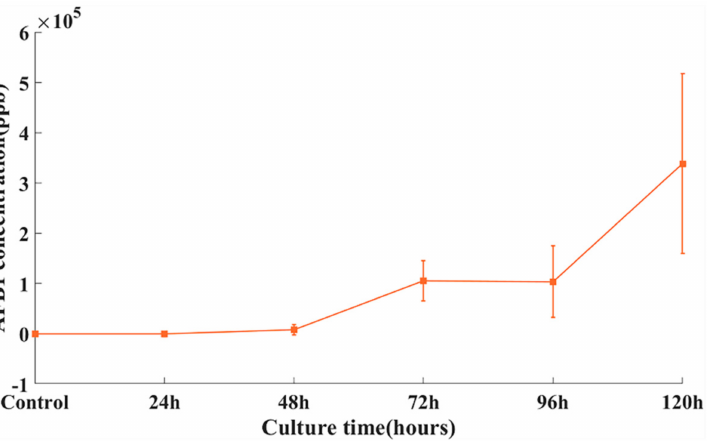
Figure 1. AFB 1 concentrations of peanut kernels inoculated with A. flavus at different time